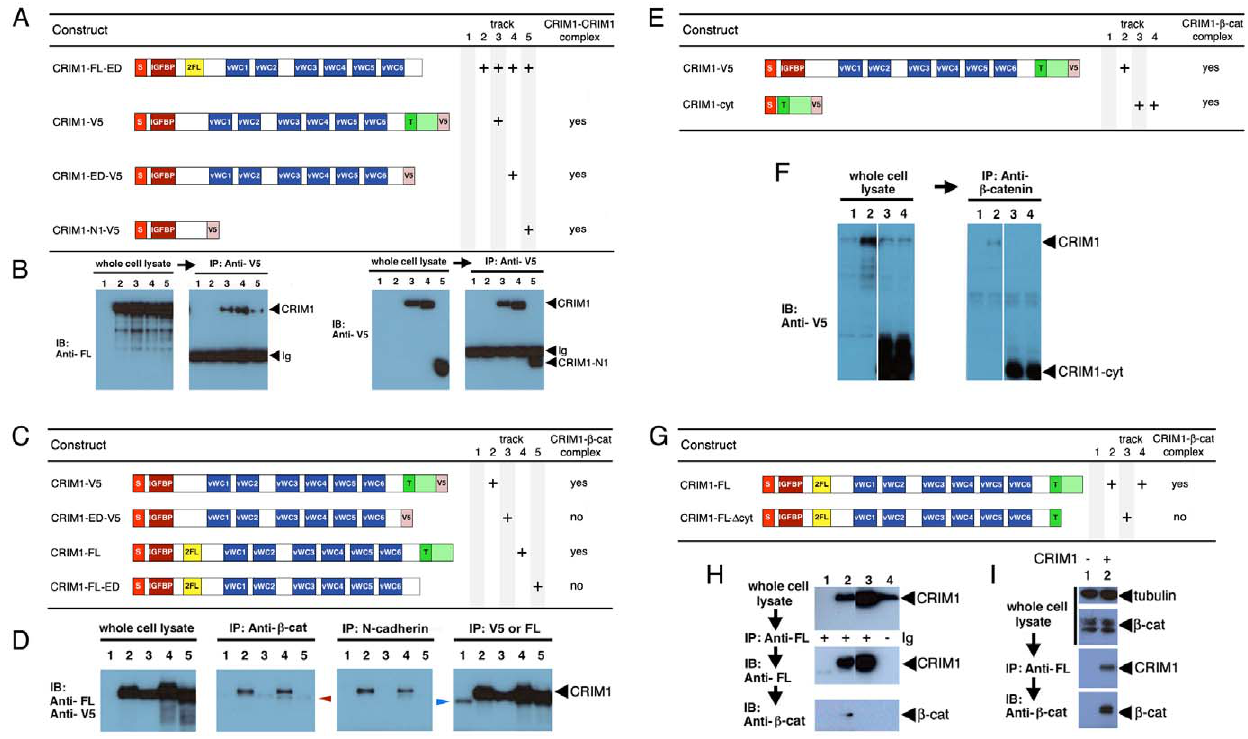
Figure 7. CRIM1 self-associates via the N-terminal domain and forms a complex with ß-catenin and N-cadherin via the C-terminal domain. ( A, C, E, G ) Tables showing CRIM1 expression constructs used in pull-down assays and result summaries. ( B ) According to anti-V5 immunoprecipitations from the same whole-cell lysates, CRIM1-V5 (track 3), CRIM1-ED-V5 (track 4) and CRIM1-N1-V5 (track 5) all interact with CRIM1- FL-ED suggesting multimerization via the N-terminal region represented in CRIM1-N1-V5. The immunoglobulin used for immunoprecipitation is detected in the immunoblot of (B), right panels of each pair (Ig). ( D ) Anti-V5 and anti-FLAG (FL) immunoblots of whole-cell lysates show all CRIM constructs shown in (C) express to abundant levels in 293 cells. Control anti-V5, anti-FLAG immunoprecipitation followed by anti-V5, anti-FLAG immunoblot shows that CRIM1 proteins are readily detected. Immunoblots of the same immunoprecipitations with anti-ß-catenin or anti-N-cadherin antibodies show that CRIM1 forms complexes with ß-catenin and N-cadherin but only if the CRIM1 cytoplasmic domain is present. The band in track 1 of D (blue arrowhead) is a background band. ( F ) Anti-V5 immunoblots of whole cell lysates (left panel) and anti-ß-catenin immunoprecipitations (right panel) show a version of CRIM1 with the signal peptide, trans-membrane domain and cytoplasmic domain forms a complex with ß-catenin. (H) immunoprecipitation using anti-FLAG antibodies in 293 cells expressing either CRIM1-FL or CRIM1-FL D cyt. ß-catenin co-immunoprecipitates with CRIM1-FL, track 2, but not with CRIM1-FL D cyt, track 3. Track 4 shows a control IP from 293 cells expressing CRIM1-FL where no primary antibody was added. No ß-catenin association is observed. ( I ) Co-immunoprecipitation of ß-catenin with FLAG-tagged CRIM1-FL with 293 whole cell lysate shows detection of endogenous ß-catenin. Anti-tubulin western blot was shown as loading control. In all experiments, an equal proportion of lysate is represented on compared gel tracks.